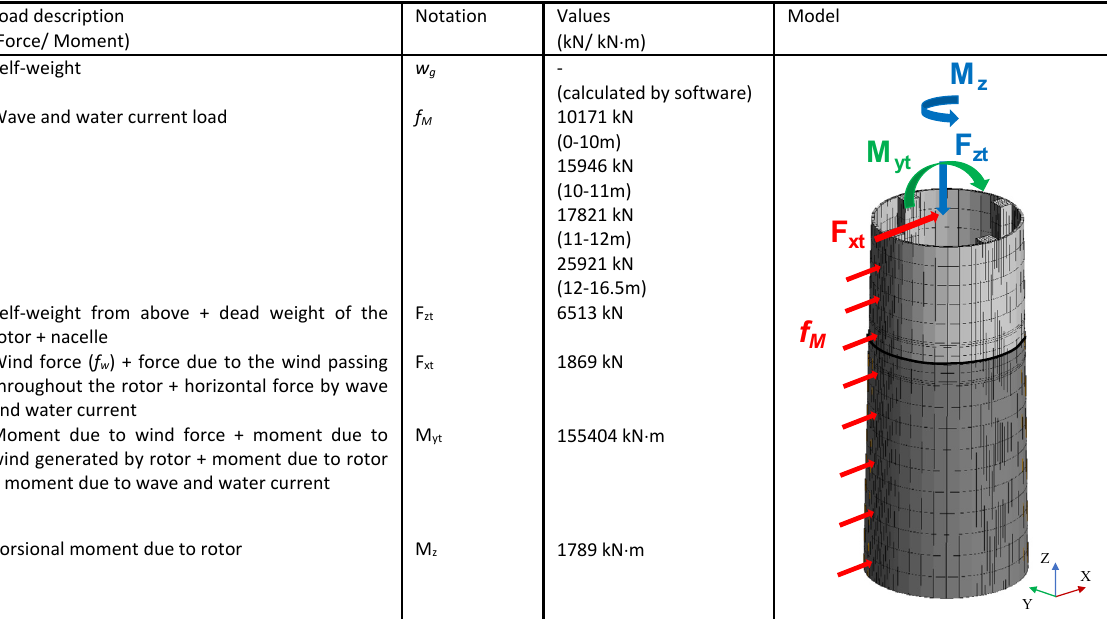
Table 2. Different loads considered for the